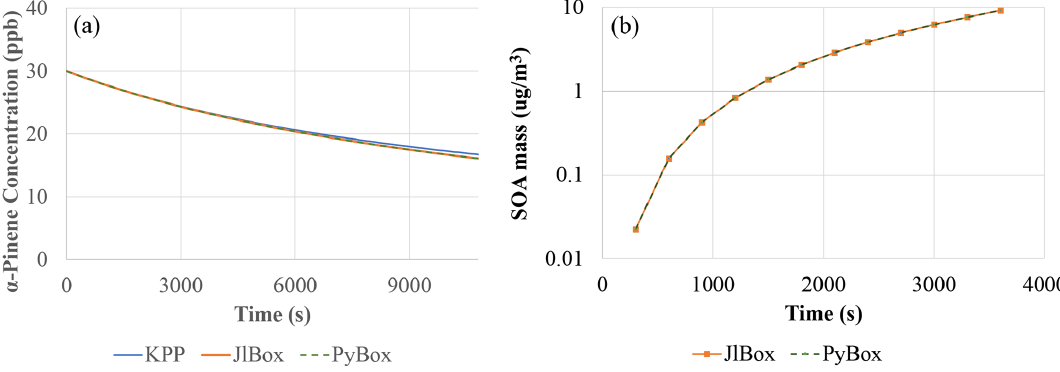
Figure 3. Comparison of gas-only (a) and multi-phase (b)